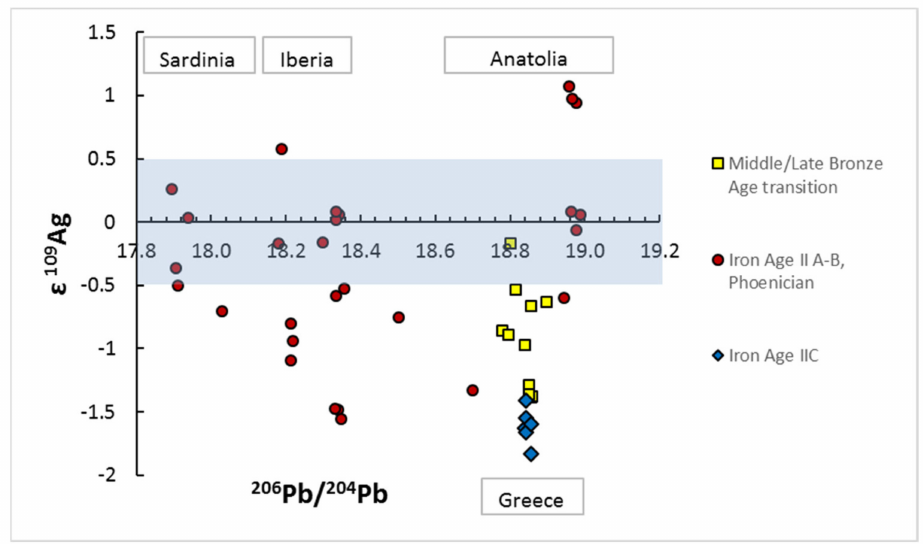
Figure 4. 206 Pb/ 204 Pb versus ε 109 Ag in silver items from Bronze and Iron Age South-Levantine hoards. The results are marked according to the different time periods: yellow squares—Middle/Late Bronze Age transition; red circles—Iron Age IIA–B (Phoenician); blue rhombuses—Iron Age IIC.